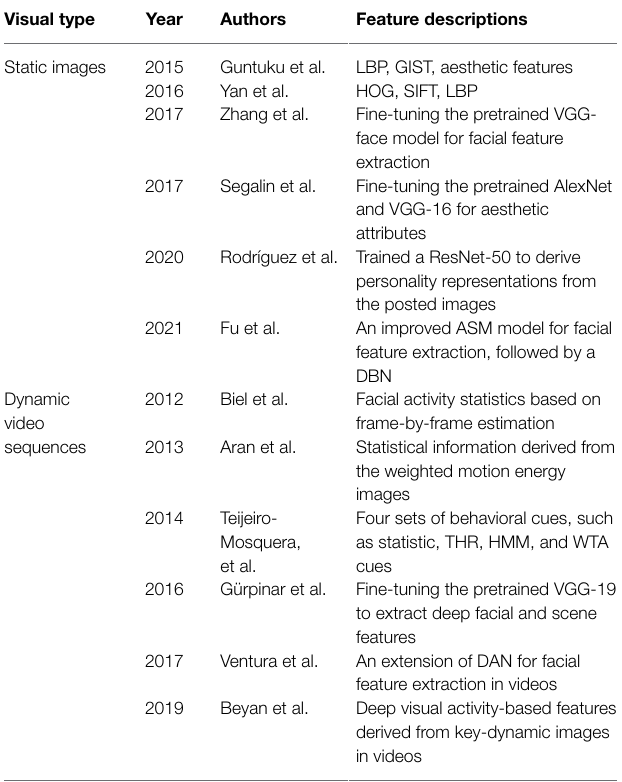
TABLE 4 | A brief summary of visual-based on personality trait